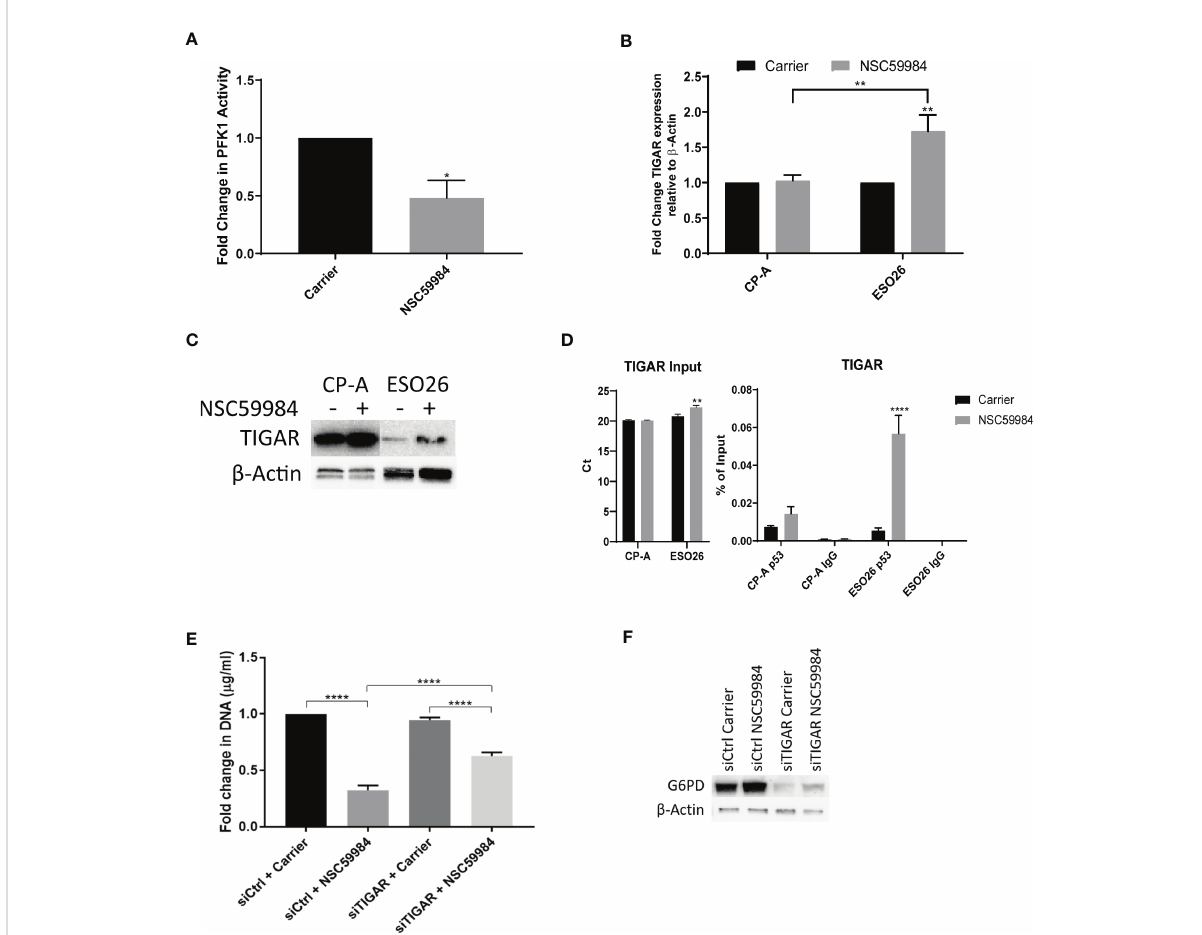
FIGURE 7 NSC59984 treatment results in p53-dependent activation of TIGAR. (A) Fold change in PFK1 activity following treatment with NSC59984 (12 m M) for 72 hr over carrier control in ESO26-R248W cells. Fold change in carrier-treated cells was normalized to 1. A paired t-test was carried out